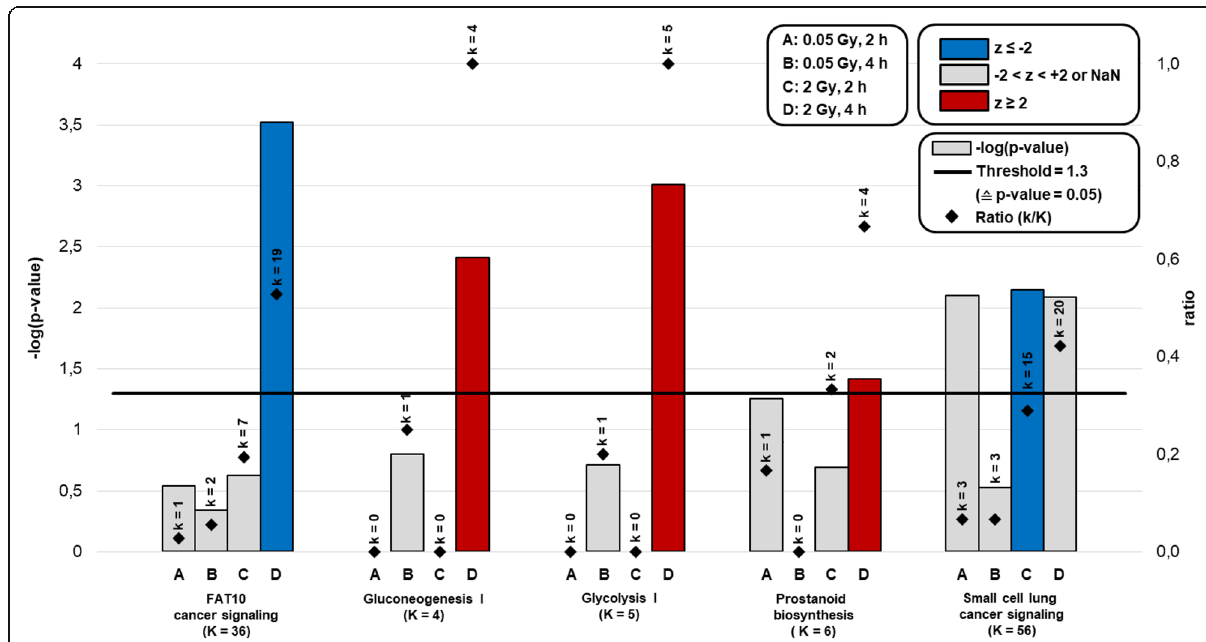
Fig. 2 Pathways affected by differentially expressed genes after high or low dose irradiation of primary human fibroblasts. Abbreviations: not a number (NaN), Gray (Gy), hours (h), Gq protein alpha subunit ( G α q ), phosphoinositide 3-kinase ( PI3K ), v-akt murine thymoma viral oncogene ( AKT ), z-score (z), number of differential expressed genes (k), number of total genes in pathway